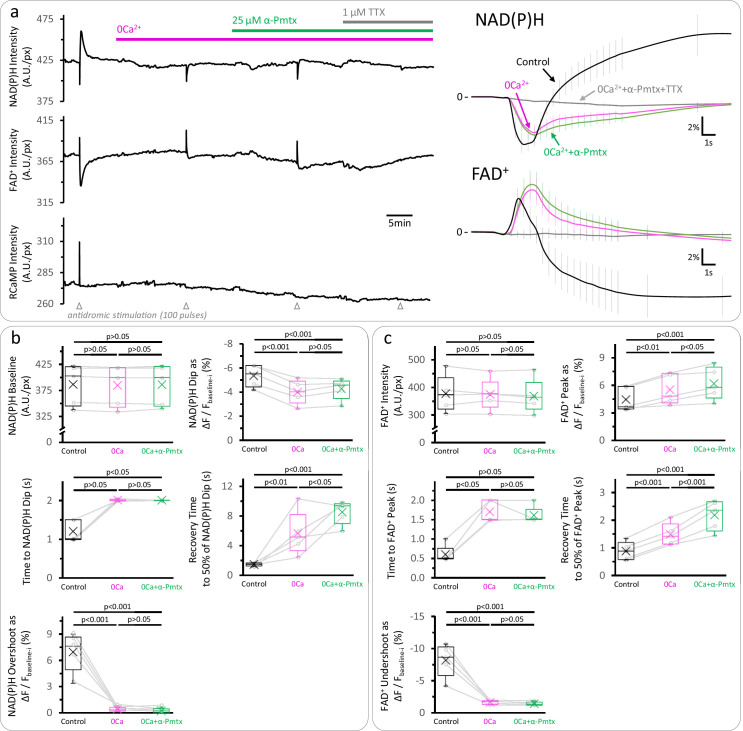
The late overshoot in the NAD(P)H signal disappears in a Ca2+-free solution and is not recovered by α-pompilidotoxin application.(a) Left: Representative trace of the autofluorescence and RCaMP signals in the DGC layer of an acute hippocampal slice. These experiments were performed with samples from juvenile wild-type mice. When Ca2+ was removed from the ACSF (as in Figure 4—figure supplement 2), the late increase (‘overshoot’) in the NAD(P)H autofluorescence and the late decrease (‘undershoot’) in the FAD+ signal were almost abolished. Reducing voltage-gate Na+ channel inactivation with 25 µM α-pompilidotoxin (α-Pmtx), which increases Na+ influx during action potentials and results in higher energy demand due to ion pumping, did not rescue any of these signals. As expected, the application of 1 µM Tetrodotoxin (TTX), a blocker of voltage-gate Na+ channels that prevents the firing of action potentials, inhibited all the signals elicited upon stimulation. Right: Average traces of the NAD(P)H and FAD+ signals, expressed as the ΔF/Fbaseline-i ratio (mean ± SD of number of slices, Nslices = 5, Nmice = 3). The initial segment of the signals was zoomed in to better visualize the effects of the manipulations on the initial transient phases of both the NAD(P)H and the FAD+ signals. (b–c) Comparisons of the parameters derived from the NAD(P)H and the FAD+ signals, respectively. While Ca2+ removal recapitulated the effects on the NAD(P)H signal, the decrease in the FAD+ undershoot was more prominent than the observed in DGCs lacking MCU. The data were compared using a repeated measures ANOVA with a Student-Newman-Keuls post-test when all the groups presented Gaussian distributions, otherwise, a non-parametric Friedman test with a Dunn post-test was performed.